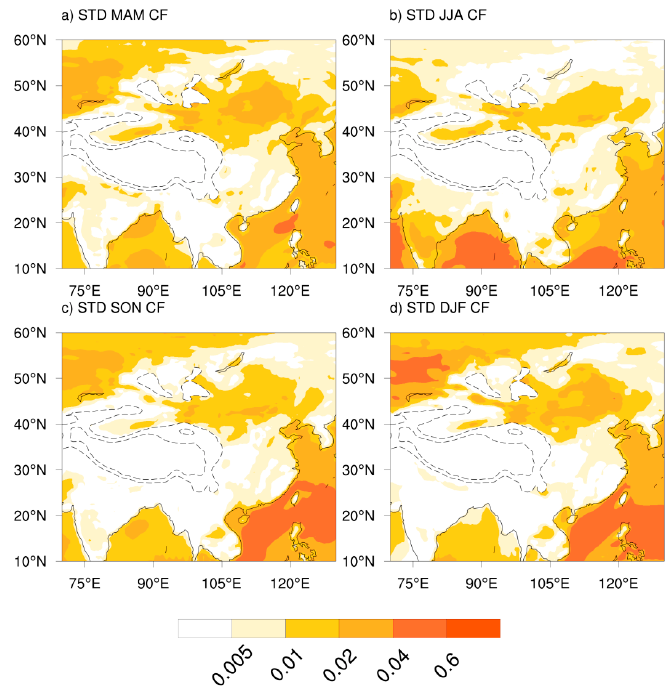
Figure 6. Standard deviation of seasonal averages of wind power capacity factor in ( a ) spring MAM, ( b ) summer JJA, ( c ) autumn SON, and ( d ) winter DJF. (Tibetan region is masked in white colour)